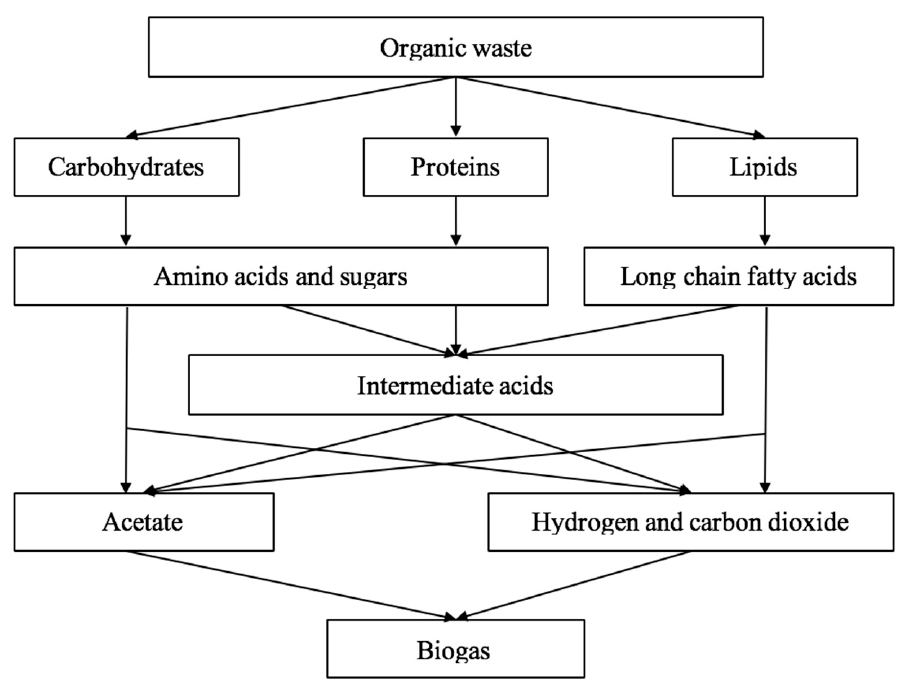
Figure 2. The anaerobic digestion influent and output streams.